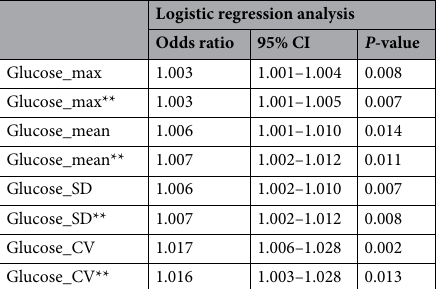
Table 2. Logistic regression analysis of in-hospital mortality. **Adjusted for age, sequential organ failure assessment score, systemic inflammatory response syndrome score, Oxford Acute Severity of Illness Score, and platelet